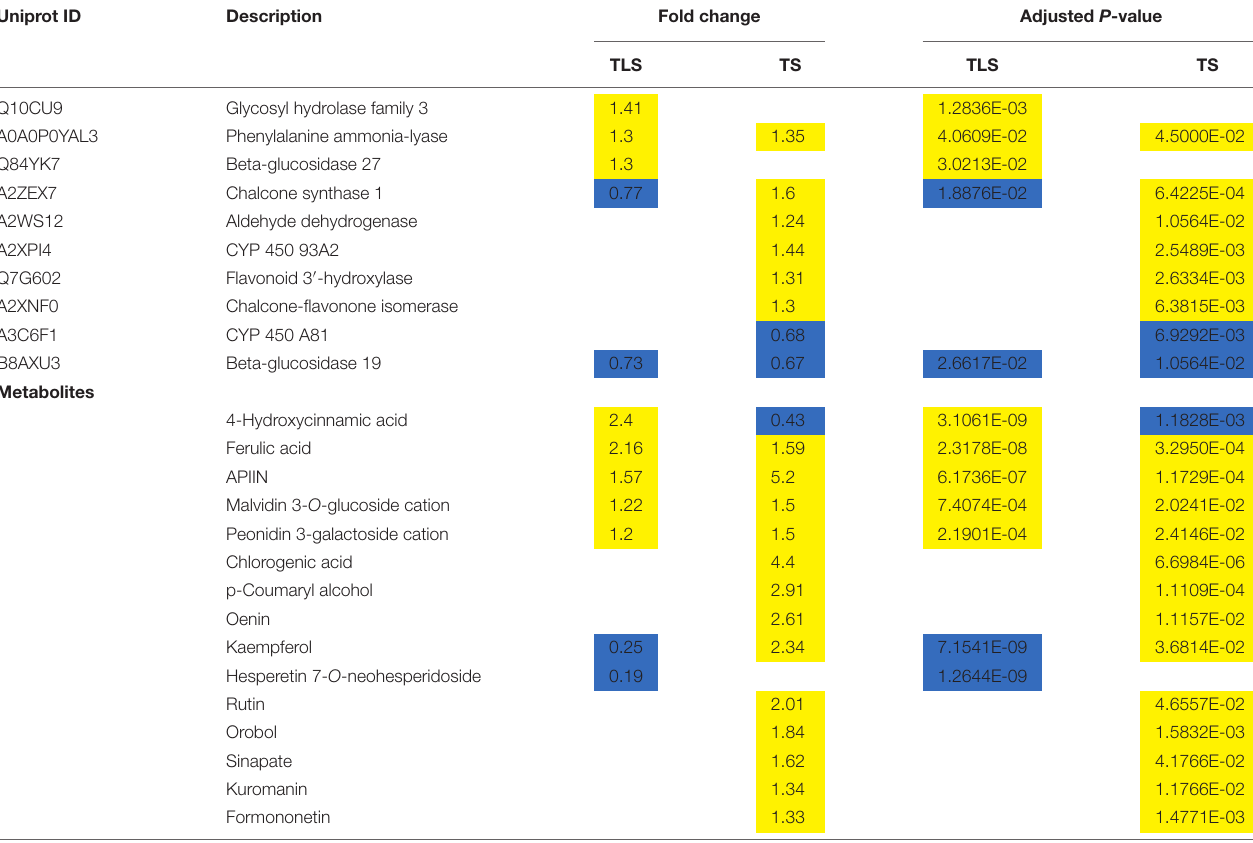
TABLE 8 | Differentially expressed proteins and metabolites related to phenylpropanoid biosynthesis pathway and flavonoid synthesis metabolism. Uniprot